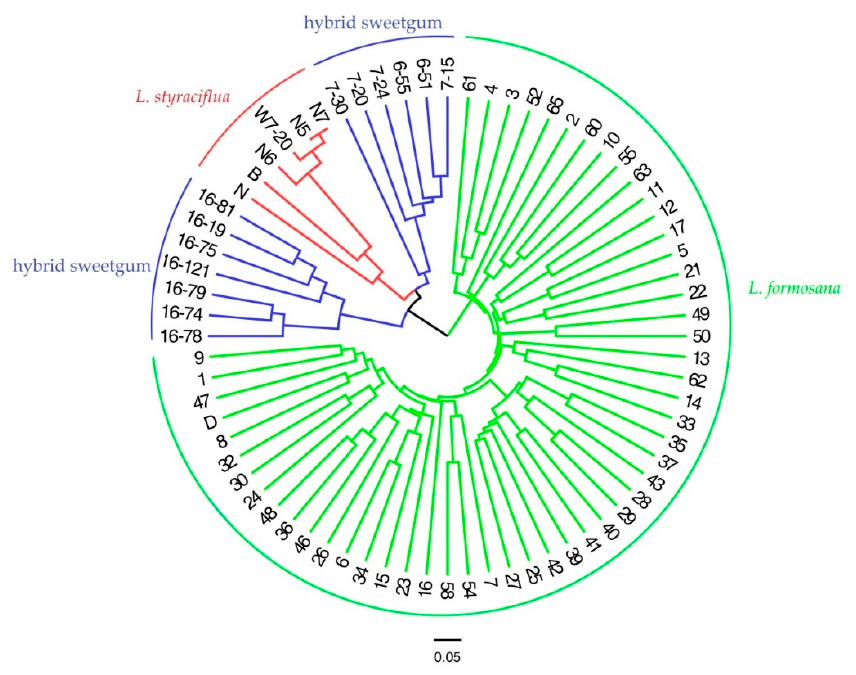
Figure 4. Genetic relationship among 72 individuals of three species Liquidambar based on 20 EST-SSR markers using neighbour-joining clustering. The 72 individuals were divided into three clusters, which are depicted with green ( L. formosana ), blue (hybrid sweetgum), and red ( L. styraciflua ) solid, respectively. The details for 72 individuals can be obtained from Table S1.